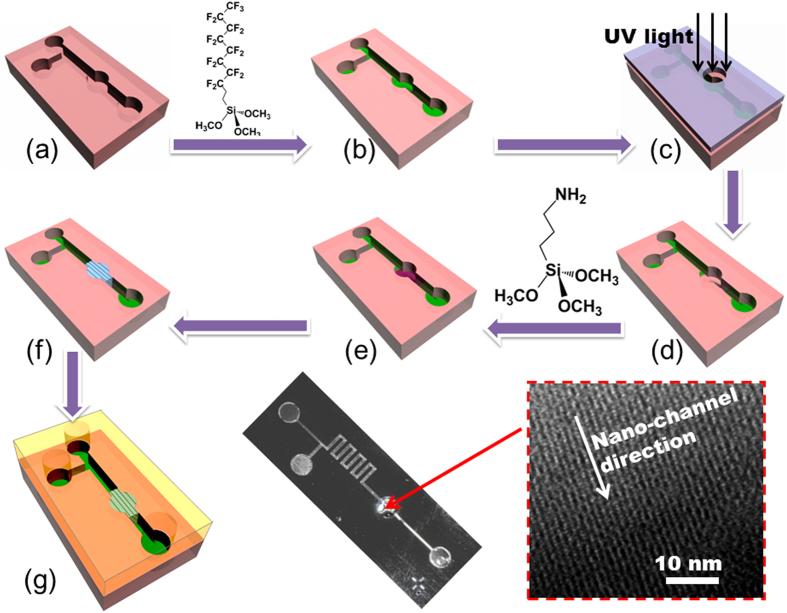
Fabrication process of the nano-channels integrated micro-chip and the optical photograph of the fabricated micro/nano fluidic chip.The transmission electron microscopy (TEM) image clearly shows the highly directional mesoporous-silica nano-channels.